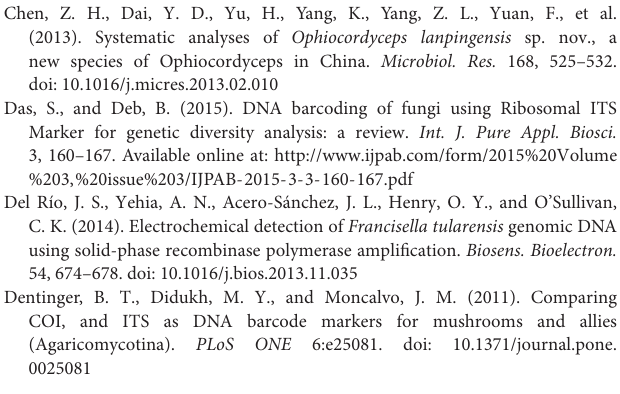
is proved to be a very efficient tool for the identification of O. sinensis and its